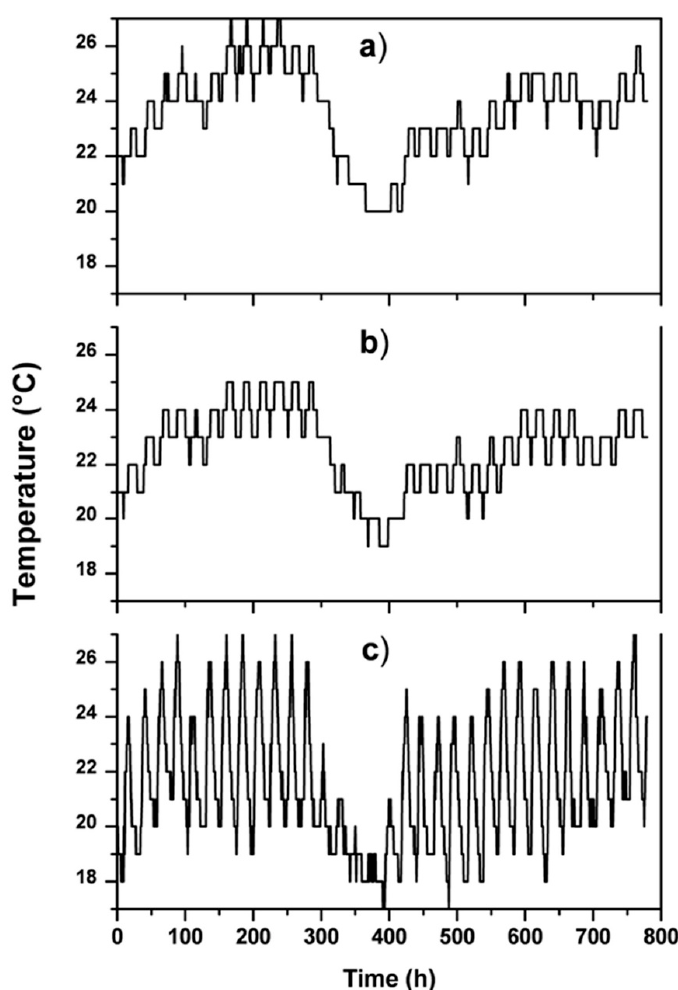
Figure 4. ( a ) Air temperature that was measured inside the prototype. ( b ) Temperature data from a sensor inside the multi-layered roof that was located in the double layer of empty opened PET bottles. ( c ) Air temperature from a reference sensor.